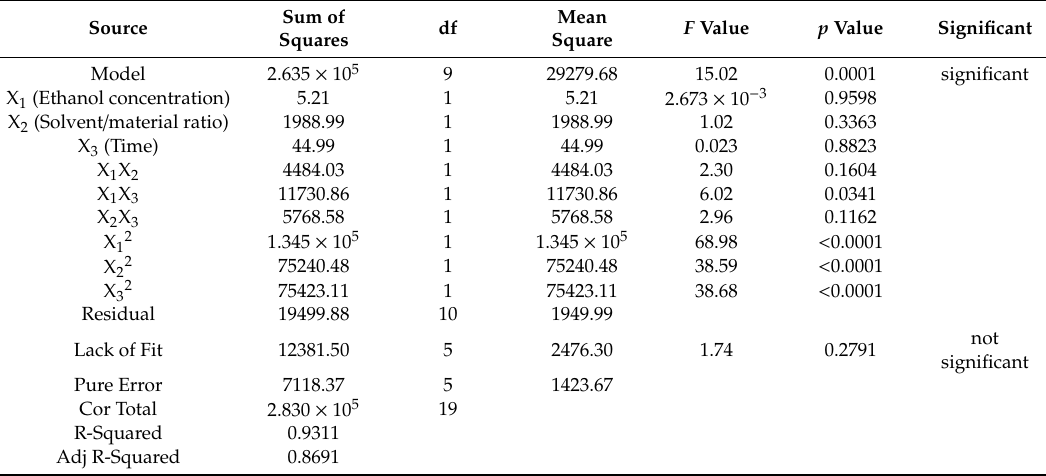
Table 3. ANOVA of the fitted polynomial quadratic